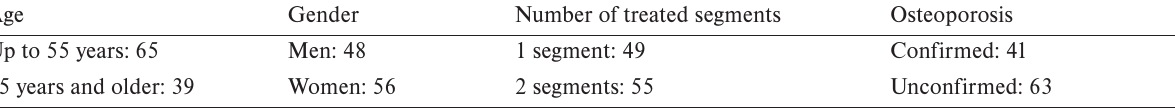
Table 2. Division of the patients’ cohort according to analysed risk factors.